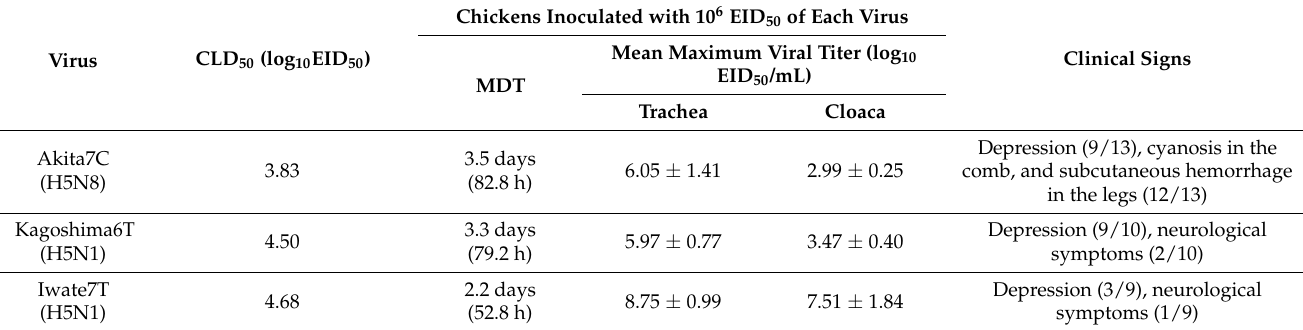
Table 1. Chicken lethal dose, mean death time, mean maximum viral titer, and clinical signs.